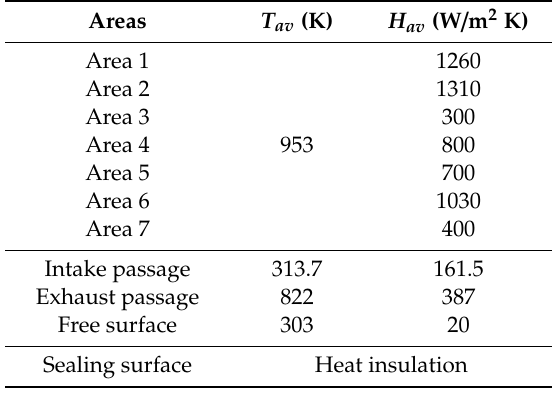
Figure 9. Areas of the cylindrical head’s flame surface. Table 5. TBCs of different areas of the cylindrical head.